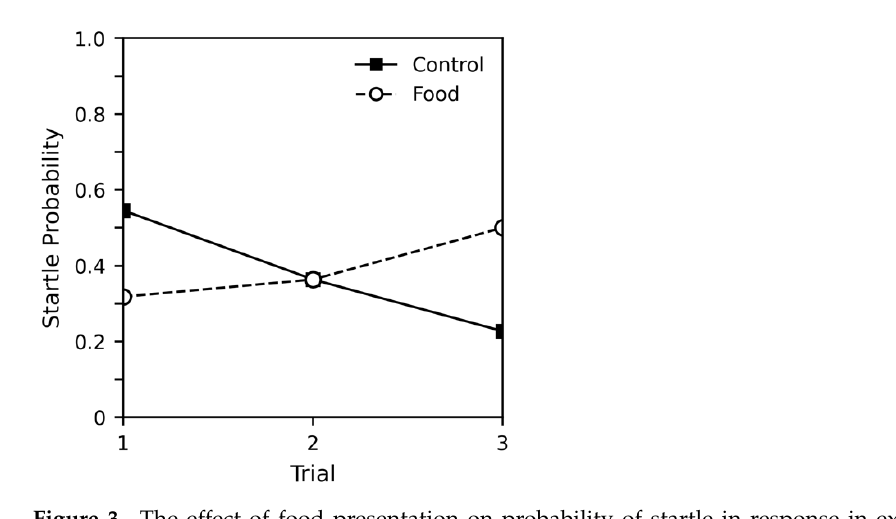
Figure 3. The effect of food presentation on probability of startle in response in experiment 3. All subjects showed a startle response when recollected after the final trial. Table 3. Experiment 3 Startle Probability Regression Analysis.